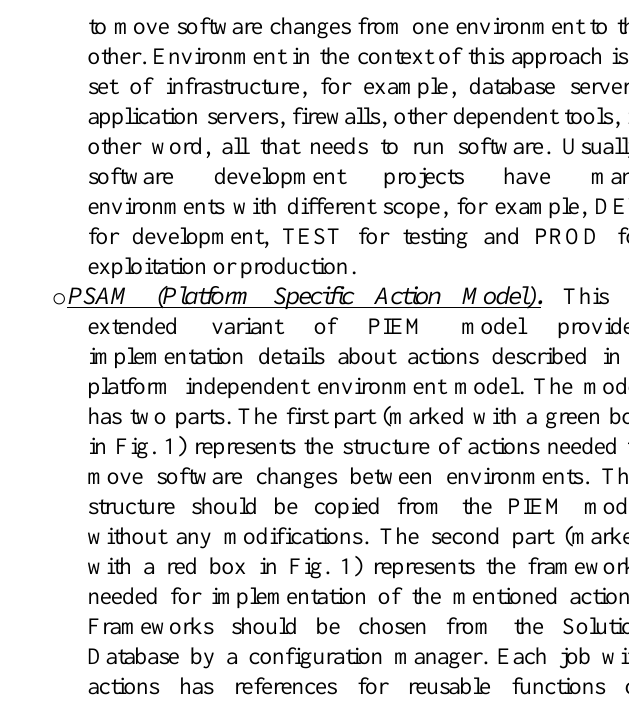
Fig. 1. Model-driven approach for implementation of software configuration